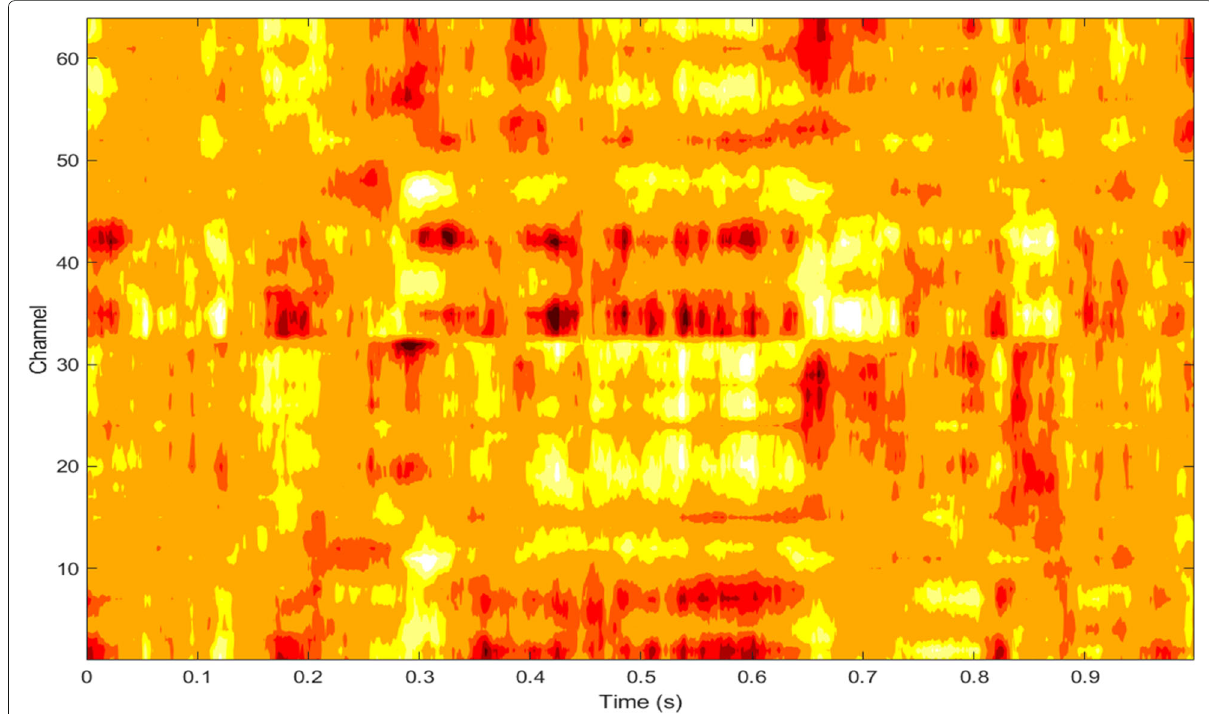
Fig. 5 Time by activity representation of ERPs after RICI for 64